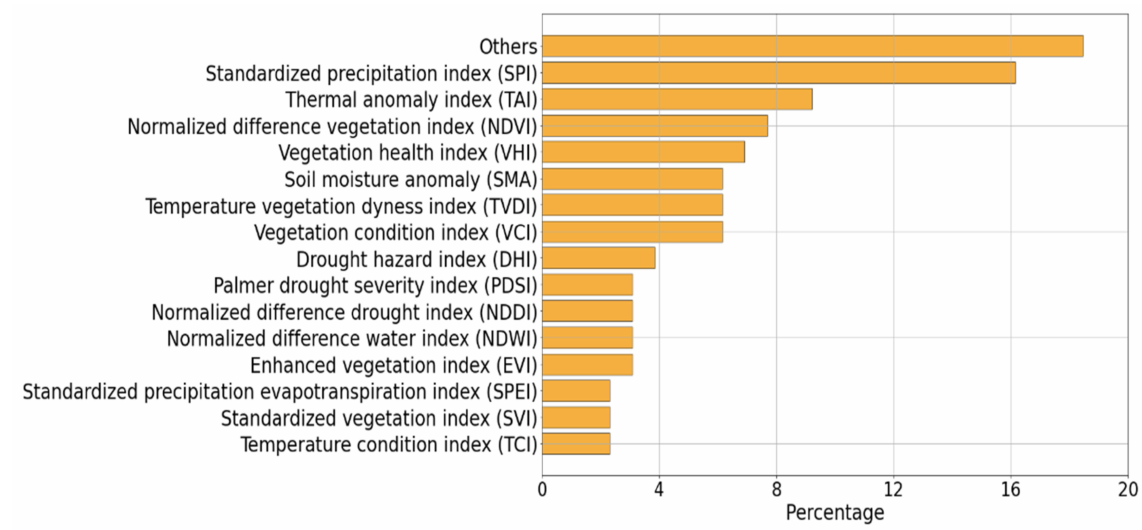
Figure 12. Drought indicators and indices used for characterizing and assessing drought conditions and their impacts in Southeast Asia over the past 21 years. The “others” indicate drought indica- tors/indices with a frequency of less than three. Many studies employed more than one drought